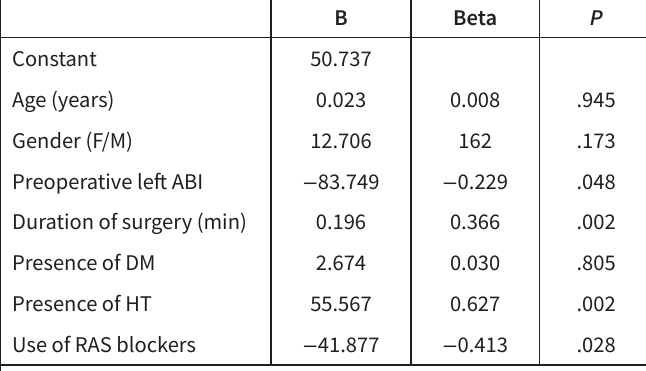
Table 4. Multivariate Analysis of Influential Parameters on the Change of Creatinine Level on Day 2 Compared to